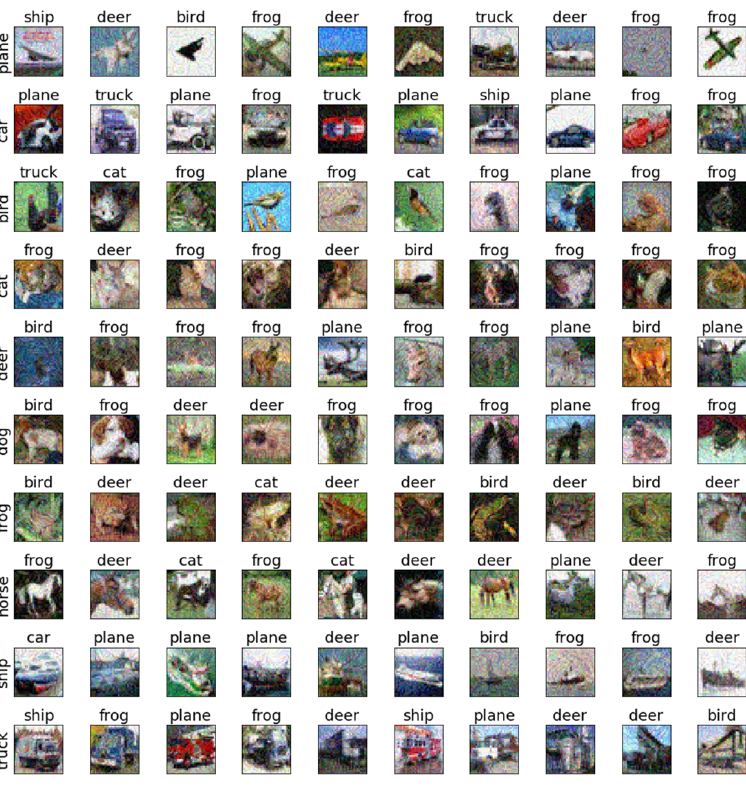
Figure 17. The adversarial examples of BMI-FGSM for Cifar10 and ResNet18.